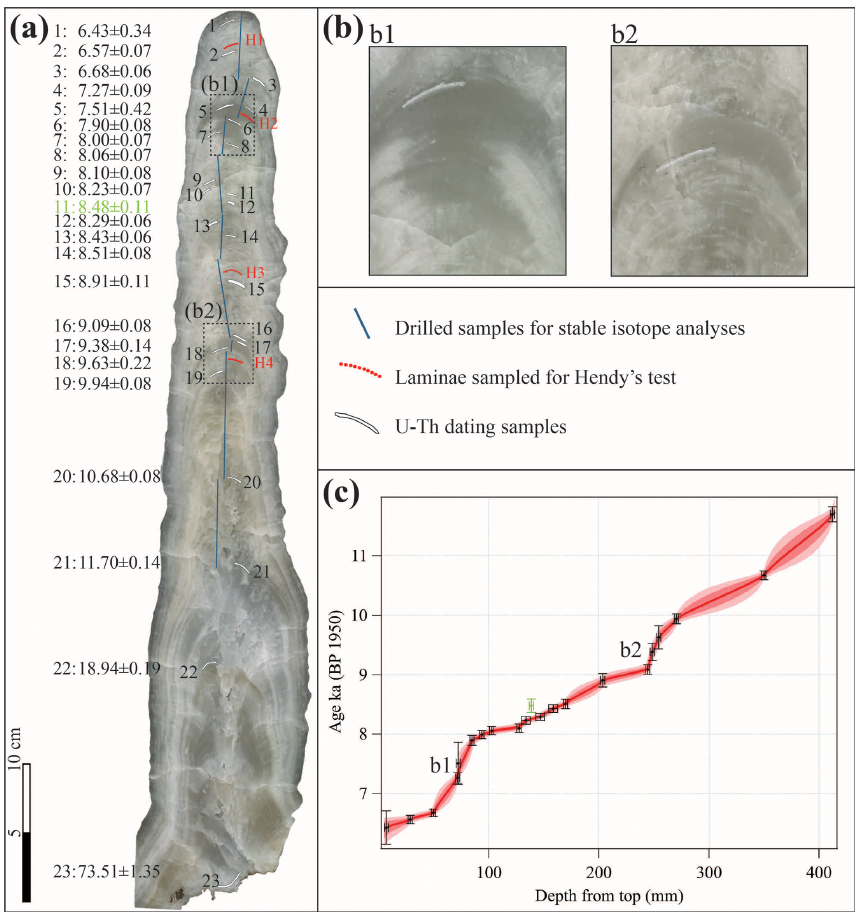
Figure 3. (a) Polished section of stalagmite SIR-14. Isotopic transects are shown as blue lines, U–Th samples are indicated in white and are numbered, and corresponding ages (in ka) are indicated to the left. Location of the laminae where the Hendy tests were performed are indicated by red lines. (b) Sections b1 and b2 show two layers of dense and dark calcite where the growth rate was relatively low (between 9.9–9.1 and 7.9–6.7ka). (c) The age–depth model for stalagmite SIR-14 created using the Finite Positive Growth Rate Model (Corrick et al., 2020). The light and dark red envelopes represent respectively the 66% and 95% confidence intervals. The date with a green symbol was treated as an outlier and excluded from the age